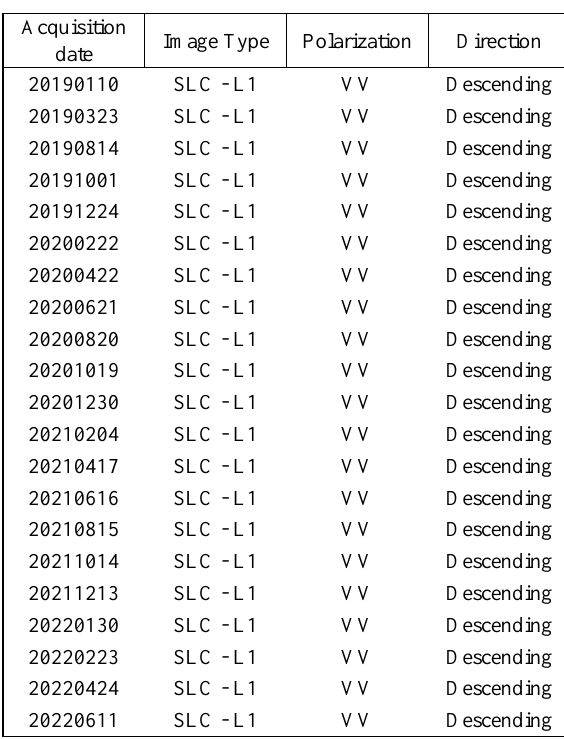
Table 1 . The characteristics of data